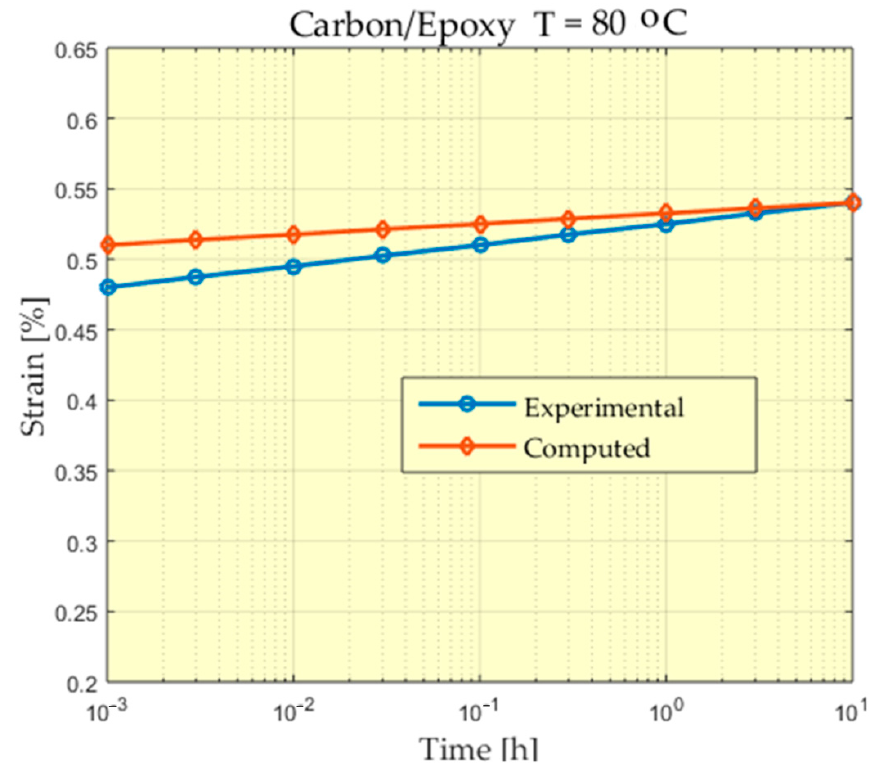
Figure 9. Comparison between experimental and theoretical prediction of creep strain for Car- bon/Epoxy subjected to 36 MPa at 80 °C.